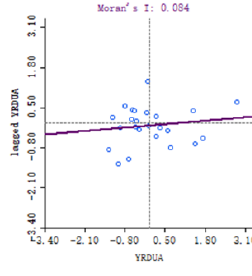
Figure 7. Spatial distribution of the coupling coordination degree for 11 urban agglomerations in China (2017). Table 3. Spatial correlation of coupling coordination degree (2014–2017).